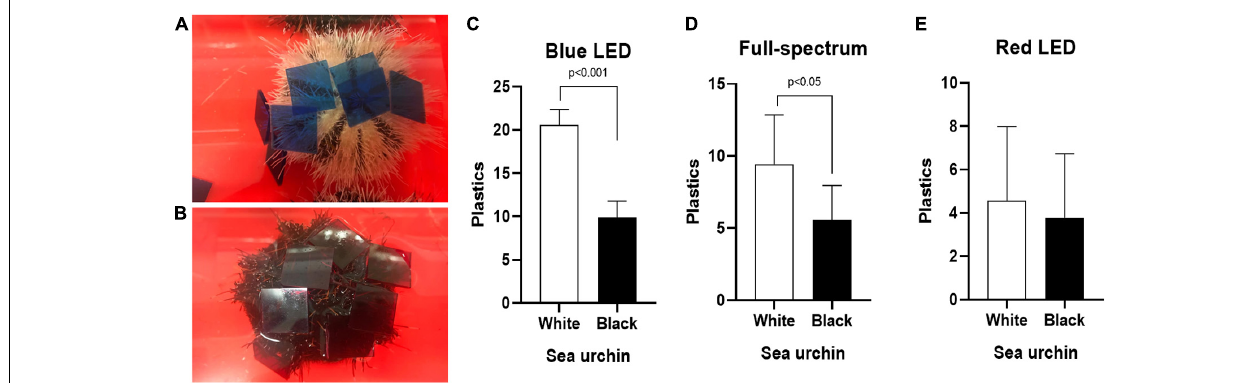
FIGURE 4 | Effects of different wavelength LED illumination on the covering behavior of (A) white and (B) black T. gratilla . The numbers of acrylic sheets gripped by sea urchin were counted after 60 min test period under (C) blue-, (D) full- spectrum-, and (E) red light source. Each value represents mean ± SD.